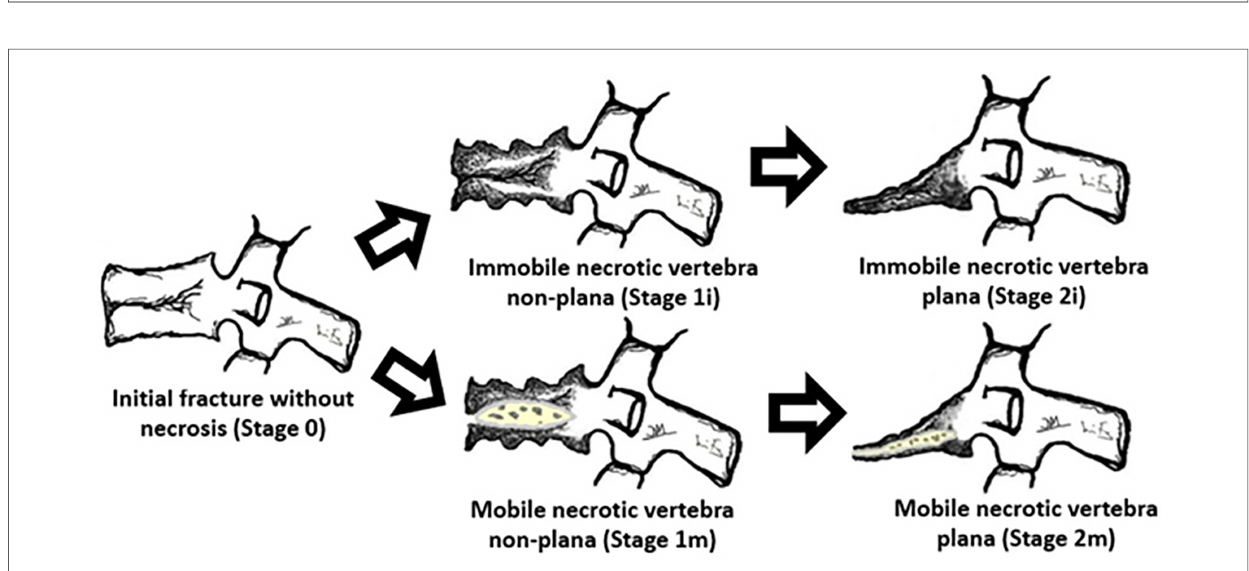
FIGURE 3 Armed kyphoplasty with VBS ® in treatment of posttraumatic vertebral necrosis with mobile vertebrae non-plana and plana. The present clinical case was a mobile vertebra plana; however, the treatment of armed kyphoplasty is similar to the one of plana or non-plana mobile necrotic vertebrae, as is illustrated in this fi gure. After removal of pseudarthrosis region (the same as the intravertebral cleft) and proper intravertebral cleaning, the implants are expanded and then fi lled with bone cement or graft (in this clinical case, we chose bone